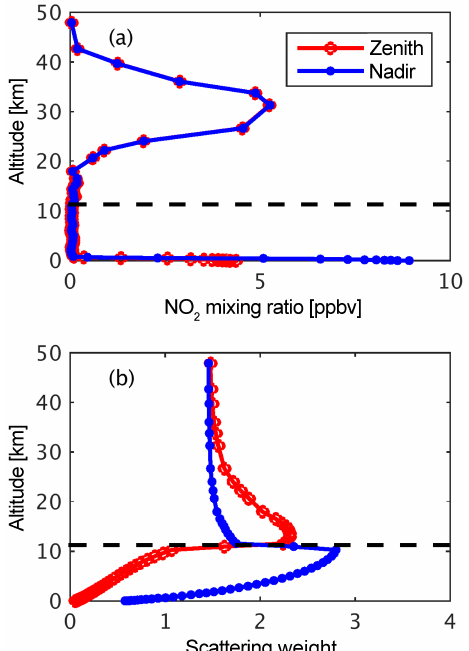
Figure 8. Sample profiles used in AMF calculation for a polluted region on 13 September 2013 10:31LT at 29.51 ◦ N and 95.34 ◦ W, with a solar zenith angle (SZA) of 47.0 ◦ and a viewing zenith angle (VZA) of 13.2 ◦ , showing (a) modeled NO 2 mixing ratio profiles for a nadir observation and a nearby zenith observation; and (b) their corresponding scattering weights. The aircraft flight altitude is shown by the black dashed line. The modeled tropo- spheric NO 2 column is 1 . 1 × 10 16 moleculescm − 2 and the retrieved is 2 . 1 × 10 16 moleculescm − 2